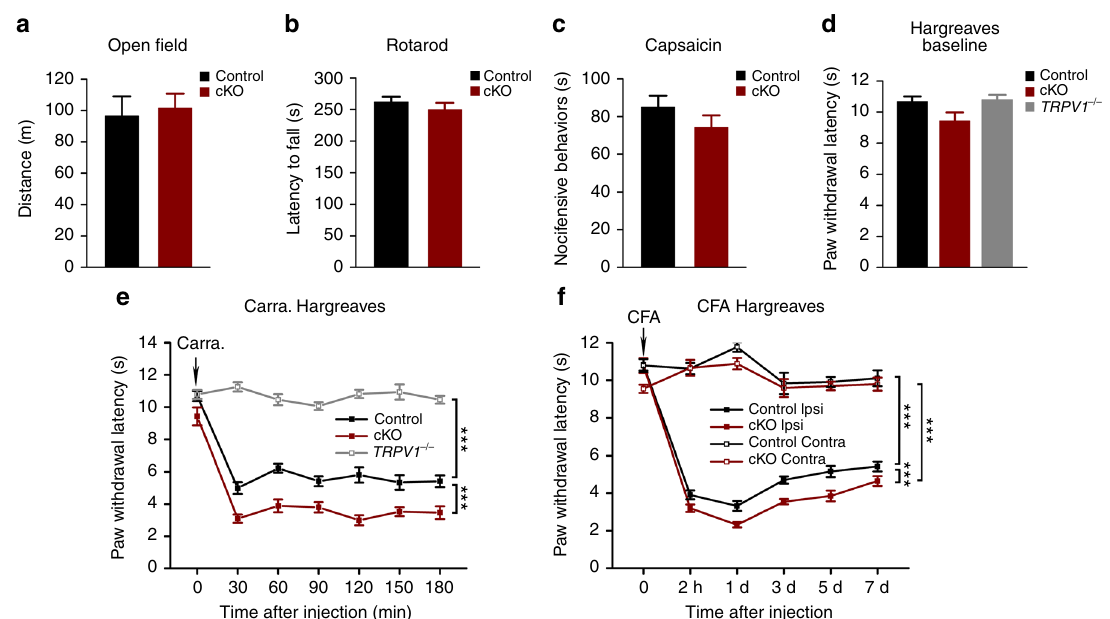
Fig. 3 Increased in fl ammatory thermal hyperalgesia in SENP1 cKO mice. a Locomotor activities and exploratory behaviors of uninjured 8-week-old SENP1 cKO mice and its littermate controls were assessed by open fi eld test. Total distances traveled during 30 min were: 96.6 ± 12.4 m for control ( n = 14) and 101.6 ± 9.2 m for SENP1 cKO ( n = 6). b Motor coordination skills for SENP1 cKO and their littermate control mice were assessed by rotarod test. The average latencies to fall from the rotating bar for three consecutive trials were: 261.7 ± 8.3 s for control ( n = 7) and 249.7 ± 10.5 s for SENP1 cKO mice ( n = 10). c Nocifensive behaviors in response to intraplantar injection of capsaicin (2 μ g) were tested for SENP1 cKO and their littermate control mice. The time spent on licking, biting, and lifting (nocifensive behaviors) within the fi rst 10 min of capsaicin injection were: 85.0± 6.0 s for control ( n = 8) and 74.3 ± 6.4 s for SENP1 cKO mice ( n = 12). d Baseline withdrawal latencies of hindpaws to radiant heat were measured for SENP1 cKO, its littermate controls and TRPV1 − / − mice by Hargreaves ’ s method. The paw withdrawal latencies (PWL) were: 10.51 ± 0.31 s for control ( n = 15), 9.43 ± 0.55 s for SENP1 cKO mice ( n = 8), and 10.79 ± 0.31 s for TRPV1 − / − ( n = 5). e Time courses of PWL as assessed by the Hargreaves ’ s method before (0 min) and at different time after intraplantar injection of carrageenan (2%, 20 μ l) into the left hindpaws of TRPV1 − / − mice, SENP1 cKO mice and their littermate controls. TRPV1 − / − mice did not develop in fl ammatory thermal hyperalgesia, whereas SENP1 cKO mice exhibited markedly decreased PWL as compared to the control in the carrageenan edema model (Control, n = 15; SENP1 cKO, n = 8; TRPV1 − / − , n = 5). *** P < 0.0001, Control vs. SENP1 cKO; *** P < 0.0001, Control vs. TRPV1 − / − . f Time courses of PWL as assessed by the Hargreaves ’ s method before (0 min) and at different times after intraplantar injection of CFA (0.5 mg ml − 1 , 20 μ l) into the left hindpaws of SENP1 cKO mice and their littermate controls. Both the left (Ipsi) and right (Contra) paws were tested (Control, n = 12; SENP1 cKO Ipsi. Data are means ± s.e.m. Two-way ANOVA for e and